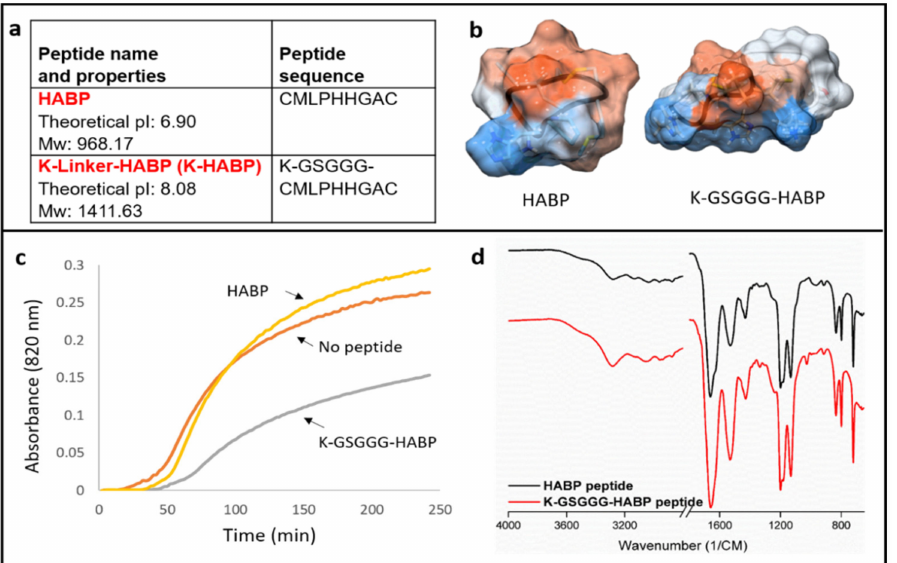
Figure 2. ( a ) Specifications of the peptides. ( b ) Three-dimensional molecular structure of HABP and K-GSGGG-HABP. ( c ) Optical density change during the mineralization media in the presence of HABP, K-GSGGG-HABP, and with no peptide. ( d ) The molecular structure of the peptides was confirmed using FTIR.